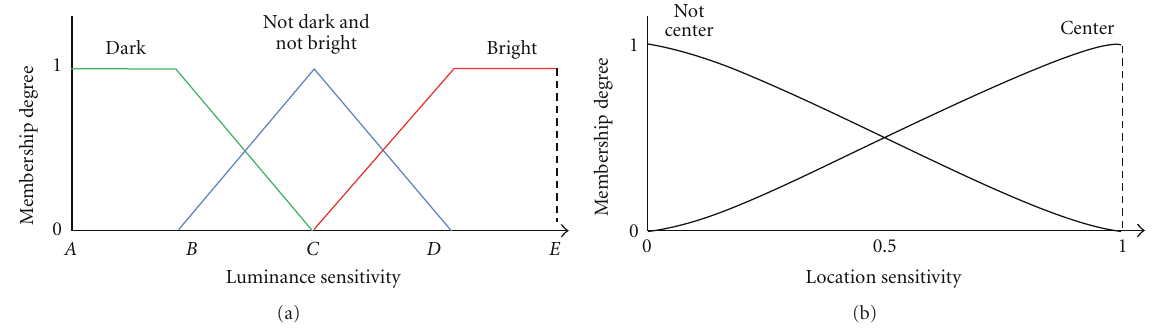
Figure 3: Membership functions for (a) luminance sensitivity and (b) location sensitivity.